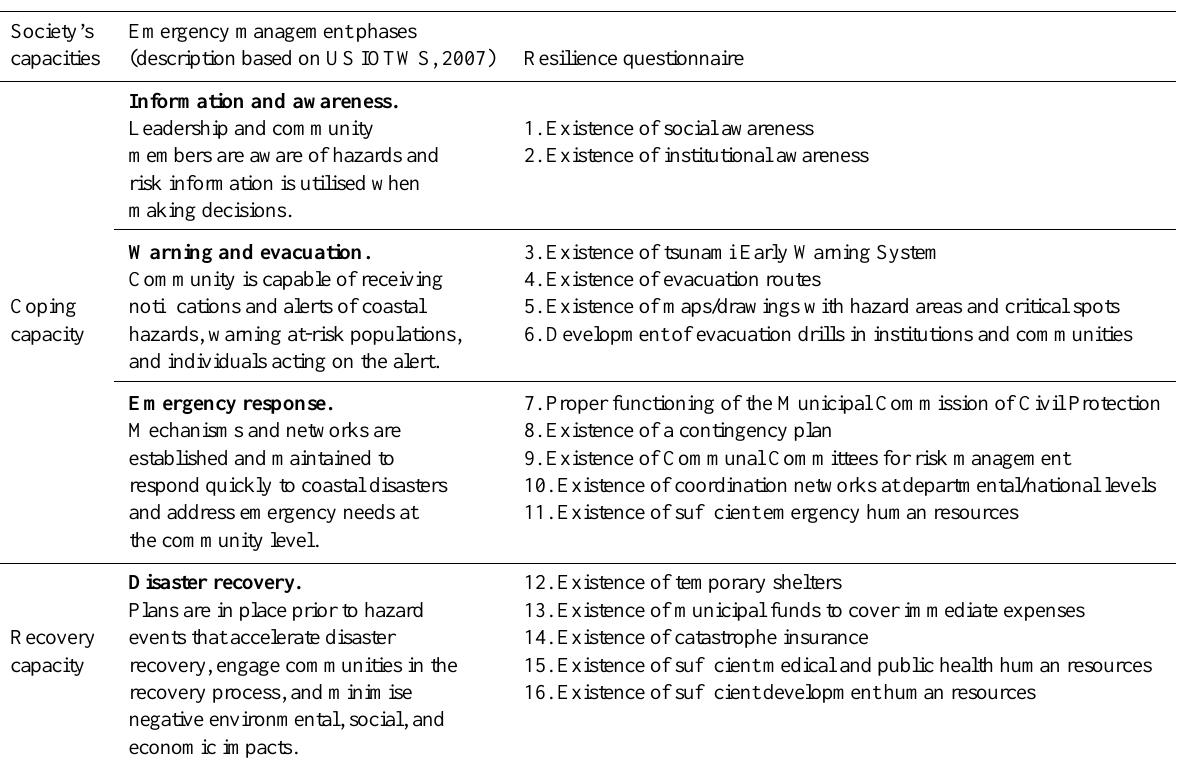
Table 3. Resilience assessment: society’s capacities, related emergency phases and questionnaire applied.